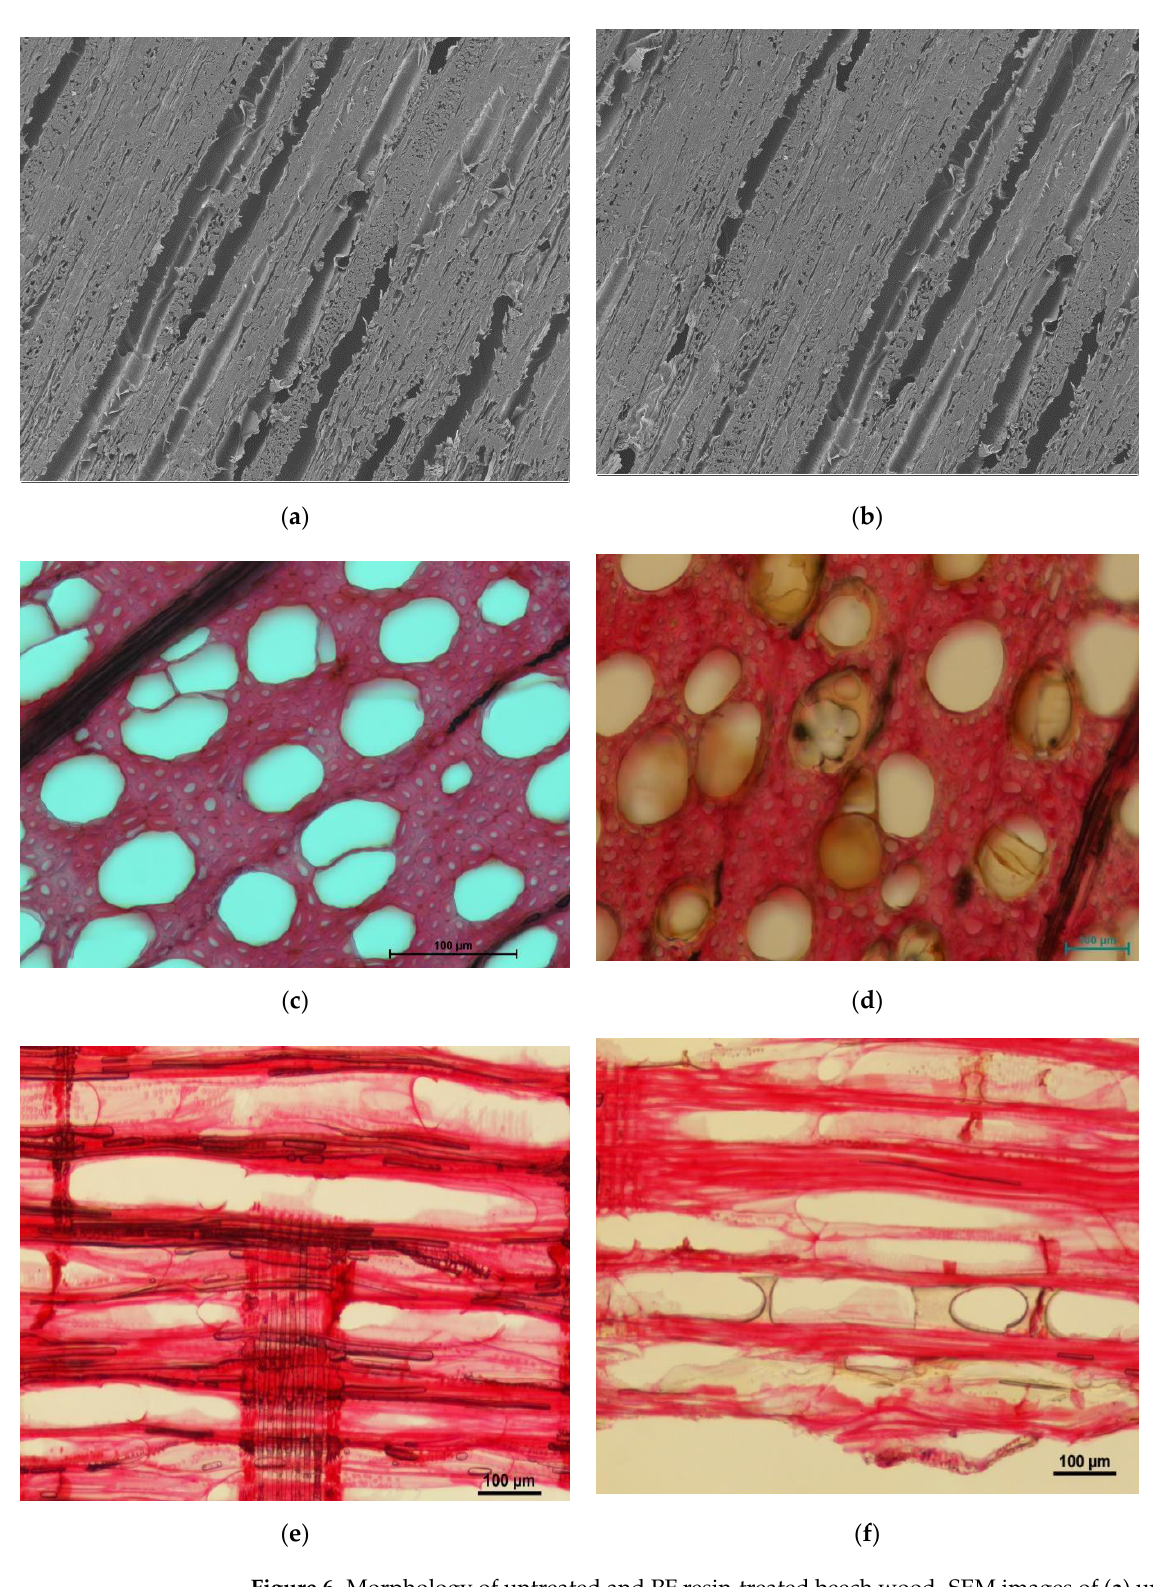
Figure 6. Morphology of untreated and PF resin-treated beech wood. SEM images of ( a ) untreated wood samples and ( b ) PF resin-treated wood samples. Light microscopy images of the transverse sections of ( c ) untreated wood samples and ( d ) PF resin-treated wood samples. Light microscopy images of the radical sections of ( e ) untreated wood samples and ( f ) PF resin-treated wood samples.